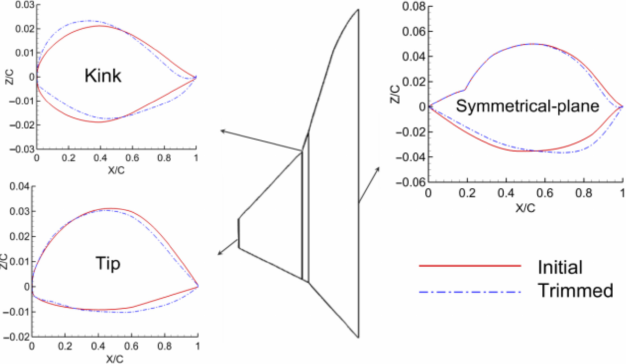
Figure 30. The difference between the initial and the trimmed configuration.